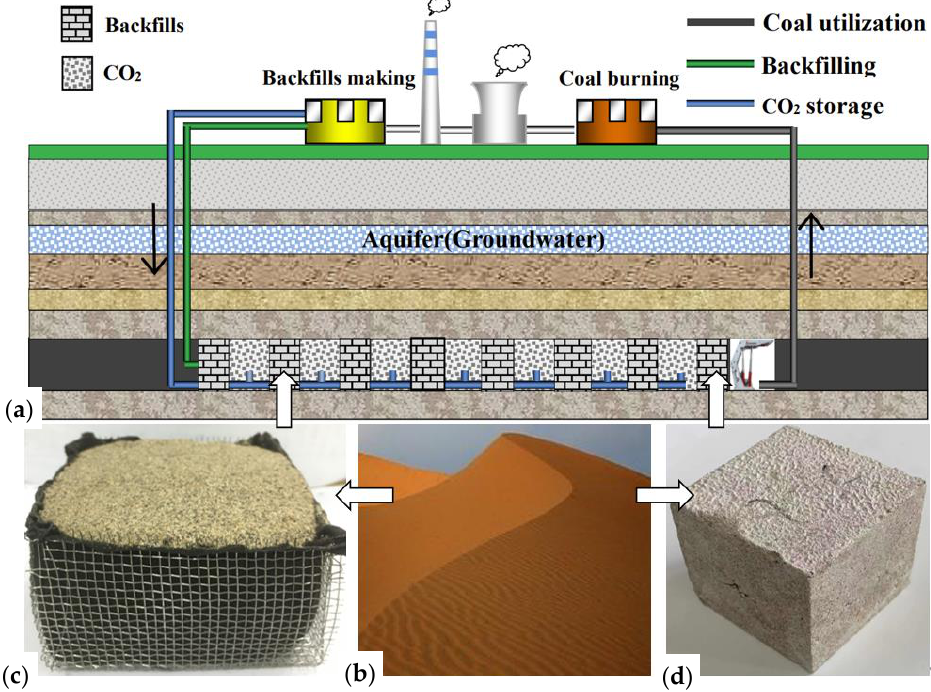
Figure 33. ( a ) A novel green mining model; ( b ) natural aeolian sand; ( c ) aeolian sand with lateral constraints; ( d ) aeolian sand with cementing